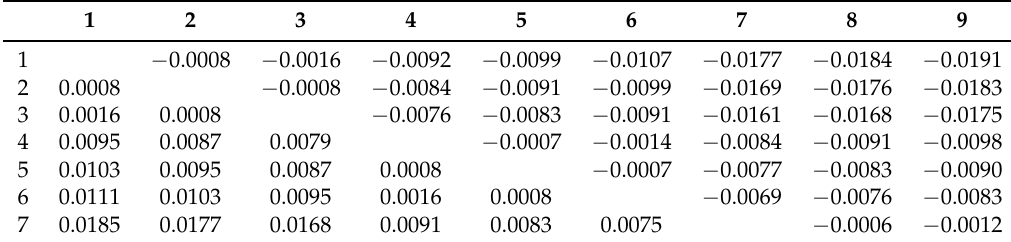
Table 2. The values of ρ ( e i − e j ) .